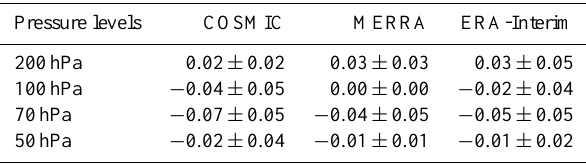
Table 2. Trends in temperature ( ◦ Cyear − 1 ) at 200, 100, 70, and 50hPa for the period August 2006 to December 2013. Uncertainties in trend estimates are reported at 95% confidence interval.